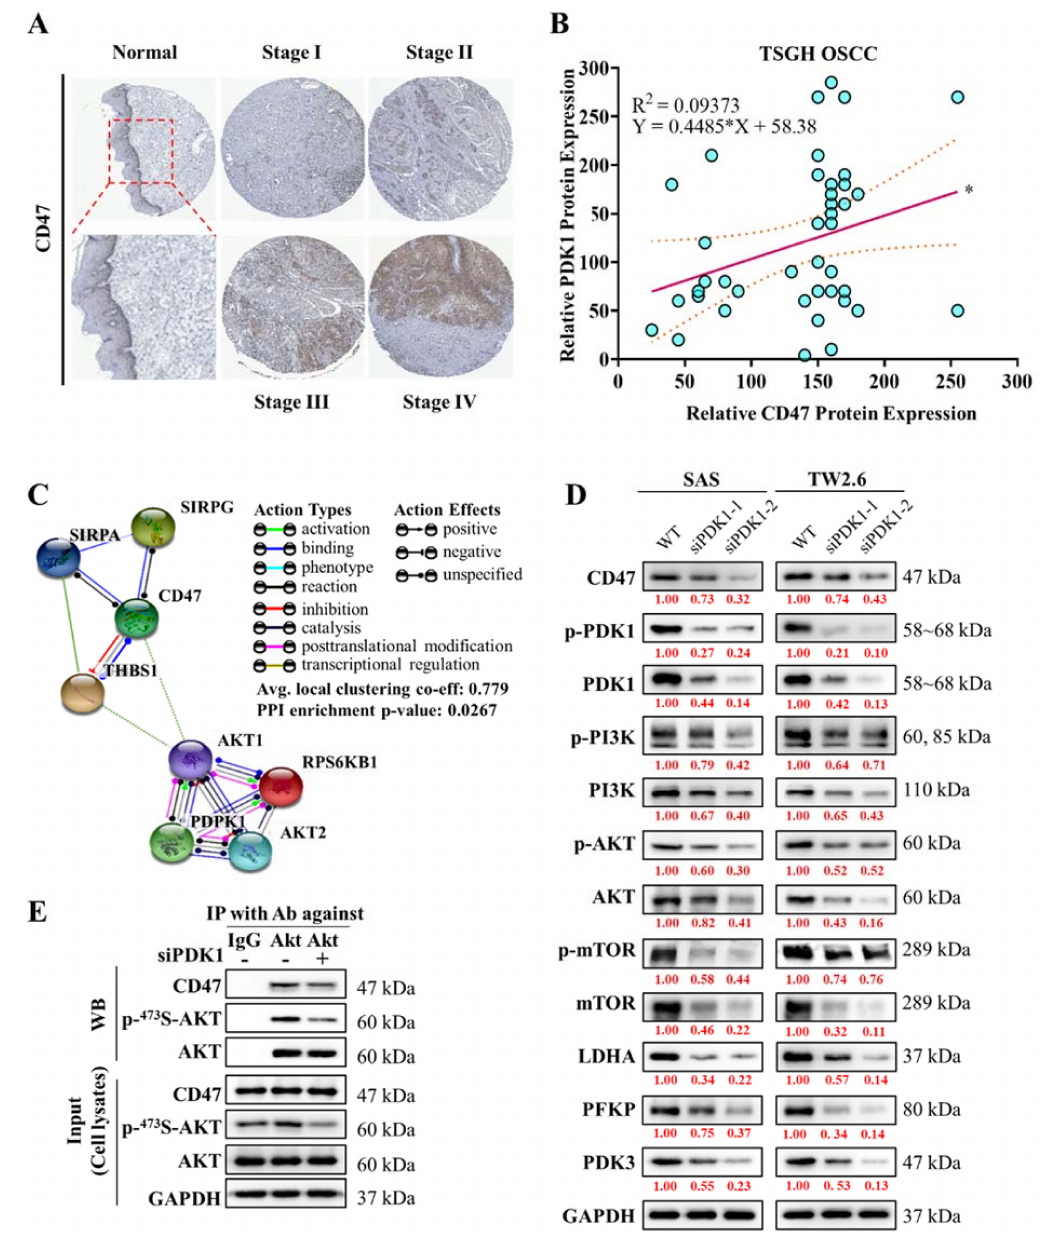
Figure 2. PDK1 is associated with increased CD47 expression through the downstream AKT and Glycolysis signaling pathway. ( A ) Immunohistochemical staining of CD47 in TSGH OSCC tissue categorized based on stages. ( B ) Graphical representation of PDK1 and CD47 protein coexpression analysis in TSGH OSCC with R 2 = 0.09373, p < 0.05. ( C ) STRING database analysis of the relationship between PDK1 ( PDPK1 ), Akt , and CD47 genes. Network nodes represent proteins encoded by the genes. ( D ) Western blotting showing differential protein expression of p-PDK1, PDK1, PI3K, p-PI3K, AKT, p-AKT, MTOR, p-MTOR, LDHA, PFKP, PDK3 and CD47 between siControl and PDK1 silencing through siPDK1-1 and siPDK1-2 transfection. ( E ) Co-immunoprecipitation analysis reveals the association of PDK1 and CD47 through Akt in SAS cells. SAS cells were transfected with siPDK1 or siControl and then equal amounts of cell lysates were immunoblotted (WB) with antibodies against CD47 , p-Ser473-Akt, or Akt (Input; lower panel), or were immunoprecipitated (IP) with anti-Akt antibody and protein A/G agarose followed by immunoblotting with antibodies against CD47, p-Ser473-Akt, or Akt (upper panel). Big data analysis revealed the potential prognostic role of assessing. All data are representative of the experiment conducted four times in triplicate and are expressed as mean ± SEM. * p <